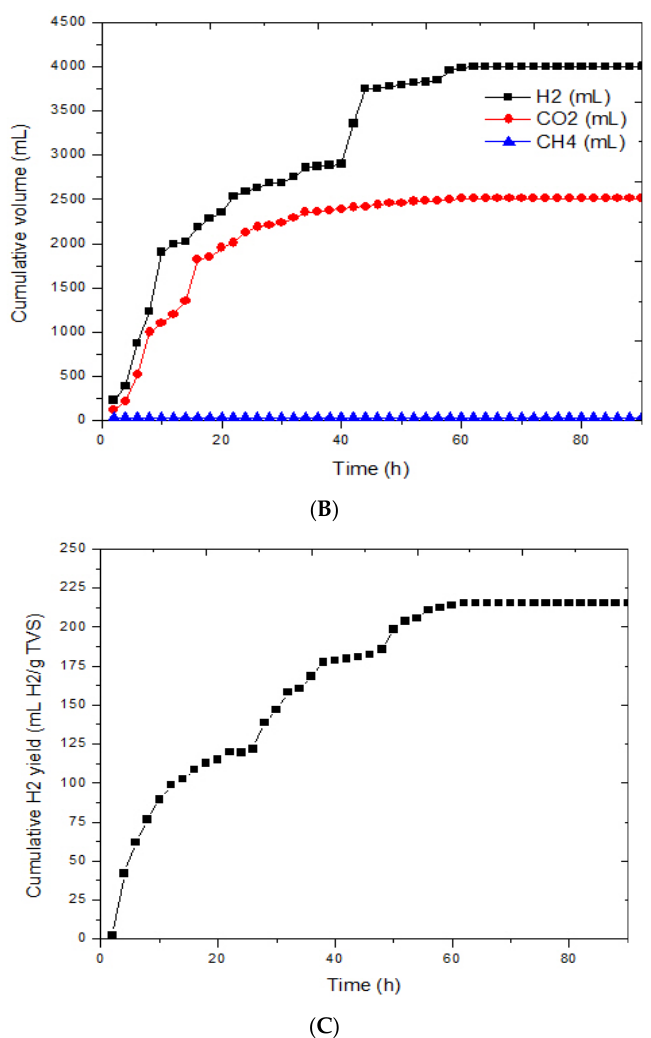
Figure 1. ( A ) Evolution of biogas fraction of hydrogen, methane and carbon dioxide; ( B ) cumulative biogas volume during biohydrogen fermentation process using immobilized bacteria; and ( C ) cumulative hydrogen yield.